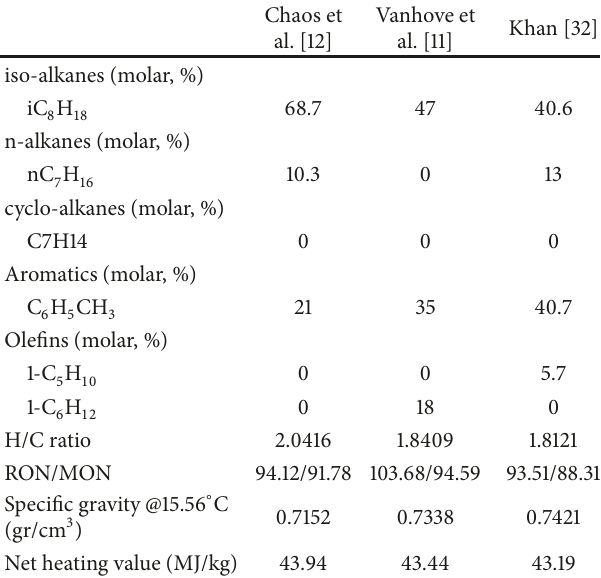
Table 10: Composition and properties of Chaos et al. [12], Vanhove et al. [11], and Khan [32]